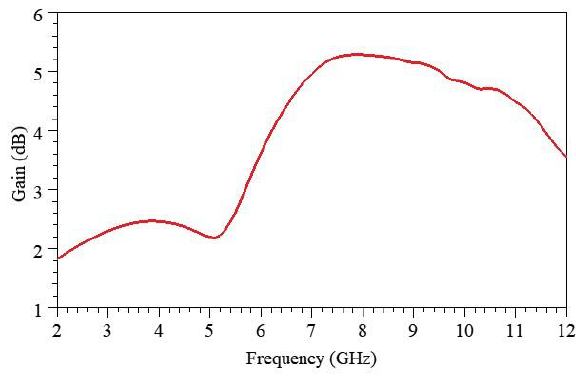
Fig. 6. Gain variation verses Frequency of HMSA